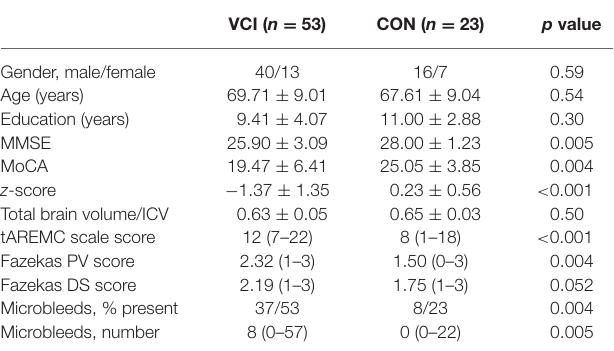
TABLE 1 | Demographic, neuropsychological data, and magnetic resonance image analysis in control and SVCI